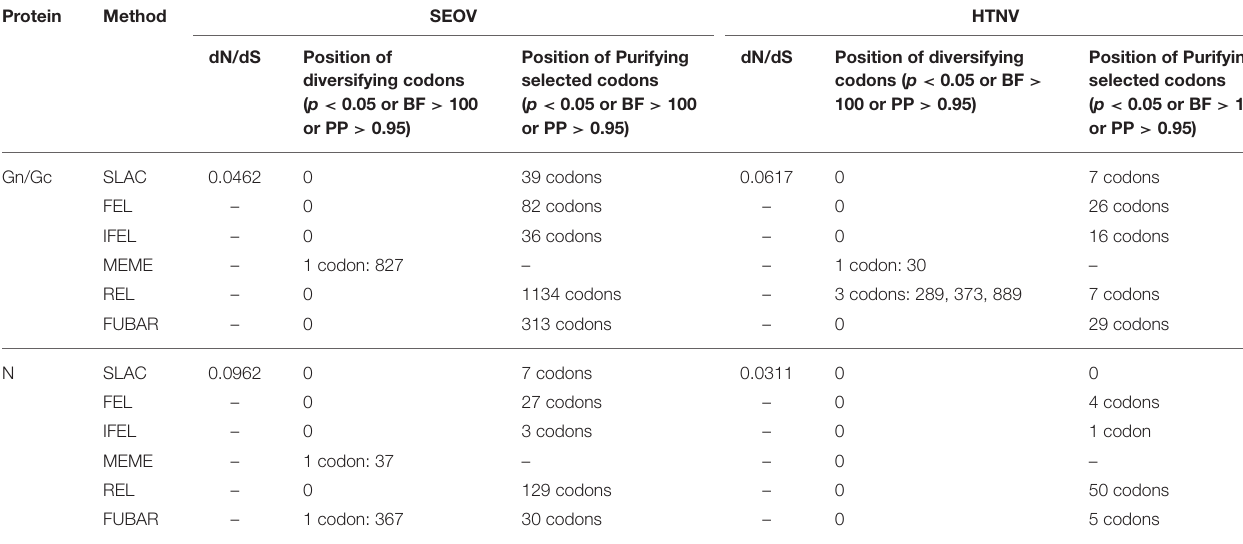
TABLE 5 | Summary of selection pressures acting on Gn/Gc protein and N protein of SEOV and HTNV obtained in this study. Protein